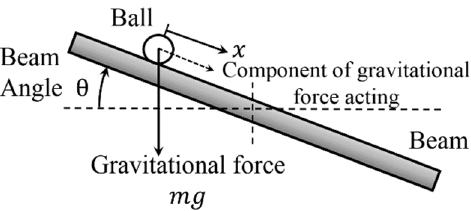
Figure 2. The movement of the sphere is affected by gravity when the beam is not on the horizontal position.